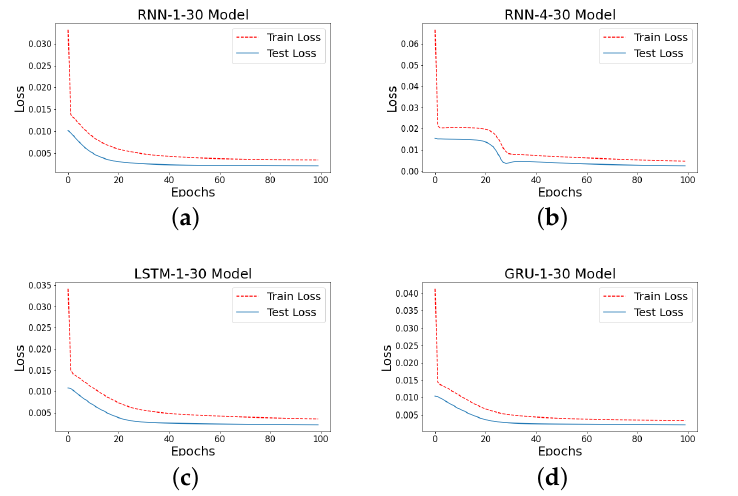
Figure 2. Convergence results for ( a ) Recurrent Neural Network (RNN)-1-30, ( b ) RNN-4-30, ( c ) Long Short-Term Memory (LSTM)-1-30, and ( d ) Gated Recurrent Unit (GRU)-1-30.